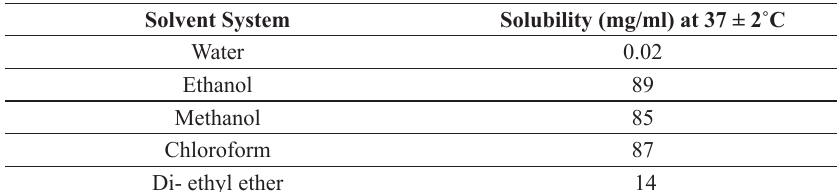
Solubility Studies of Clotrimazole in various Solvent Systems at 37 ± 2˚Cfor 48